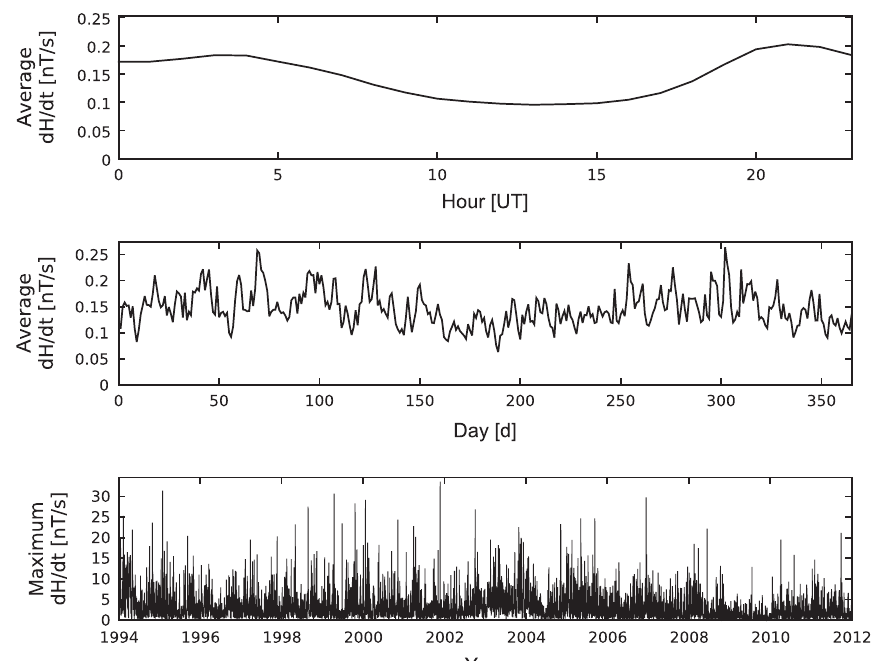
Fig. 5. Average value of the hourly maximum of the time derivative of the geomagnetic field, average value of the daily maximum of the time derivative of the geomagnetic field and daily maximum of the time derivative of the geomagnetic field at Tromsø in